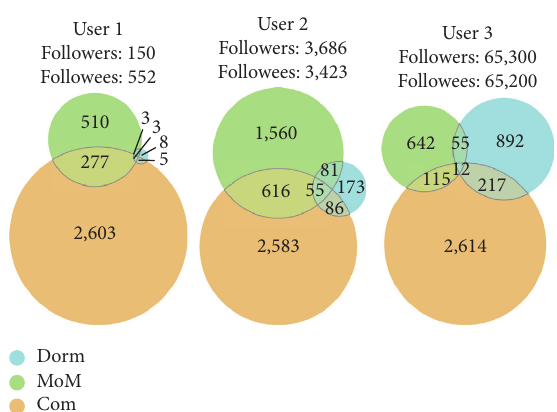
Figure 2: The sizes of recommendation pools and intersections per each structural network position for three example users with different numbers of followers and followees. The size of the Dorm group is most directly related to the number of followers/followees, while the size of MoM is affected more by activity in terms of